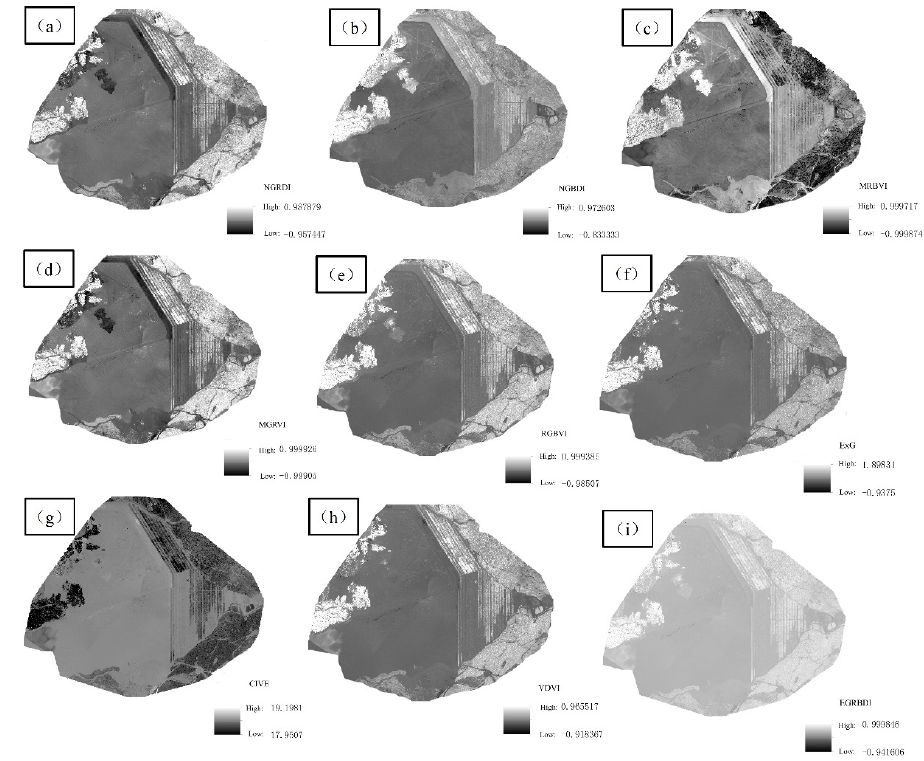
Figure 12. ( a – i ) Calculation results of each visible VI. Table 3. Error statistics of four land types of